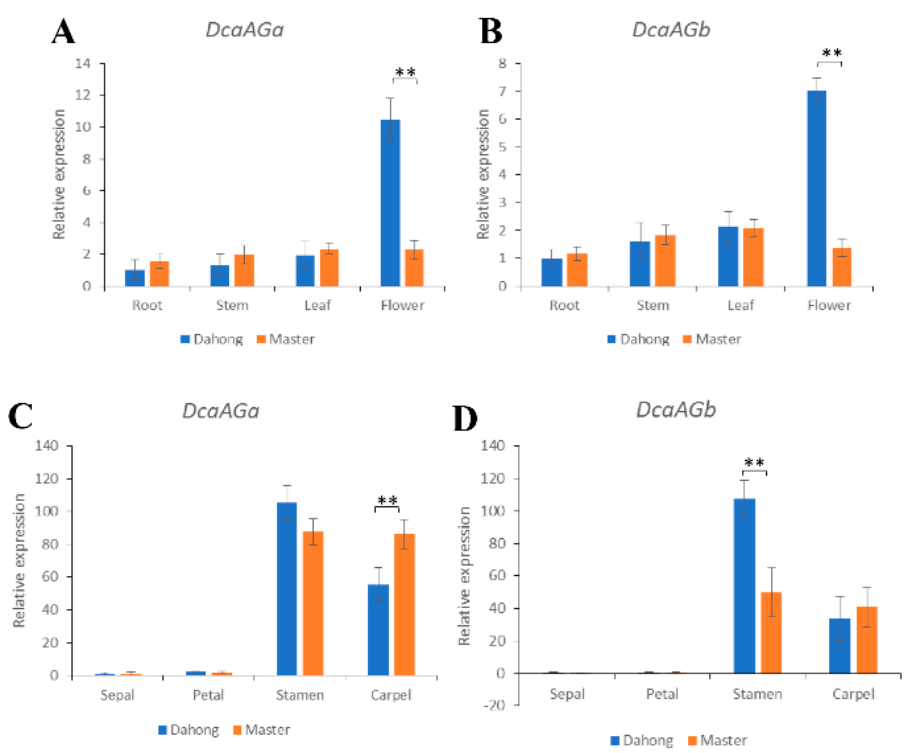
Figure 5. Quantitative PCR analysis of two DcaAG genes at di ff erent tissues ( A , B ) and floral organs ( C , D ) in single and double flower phenotype carnations. In di ff erent tissues, the expression of DcaAGa ( A ) and DcaAGb ( B ) were obviously di ff erent in the flower bud, and no significant di ff erence was detected in the root, stem and leaf between two flower phenotype carnations. In floral organs, the expression of DcaAGa ( C ) and DcaAGb ( D ) were exclusively expressed in the stamen and carpel, and low expression levels were detected in the sepal and petal. DcaAGa ( C ) and DcaAGb ( D ) showed significant di ff erential expression in the carpel and stamen between two flower phenotype carnations, respectively. ** indicates p < 0.01 by student’s t -test.